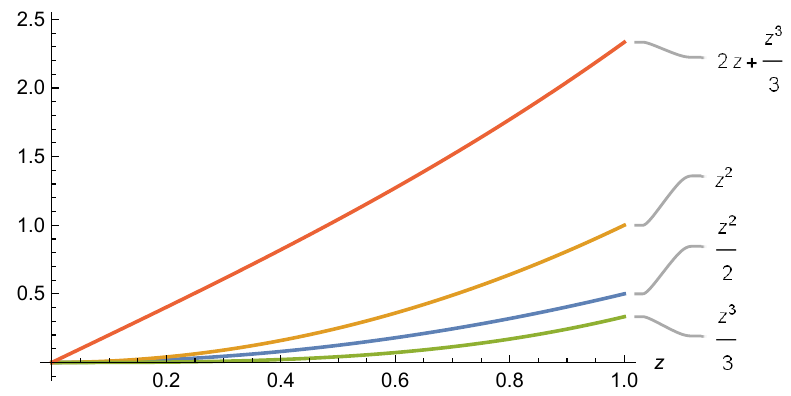
Figure 2. It is evident from the graph that Theorem 4